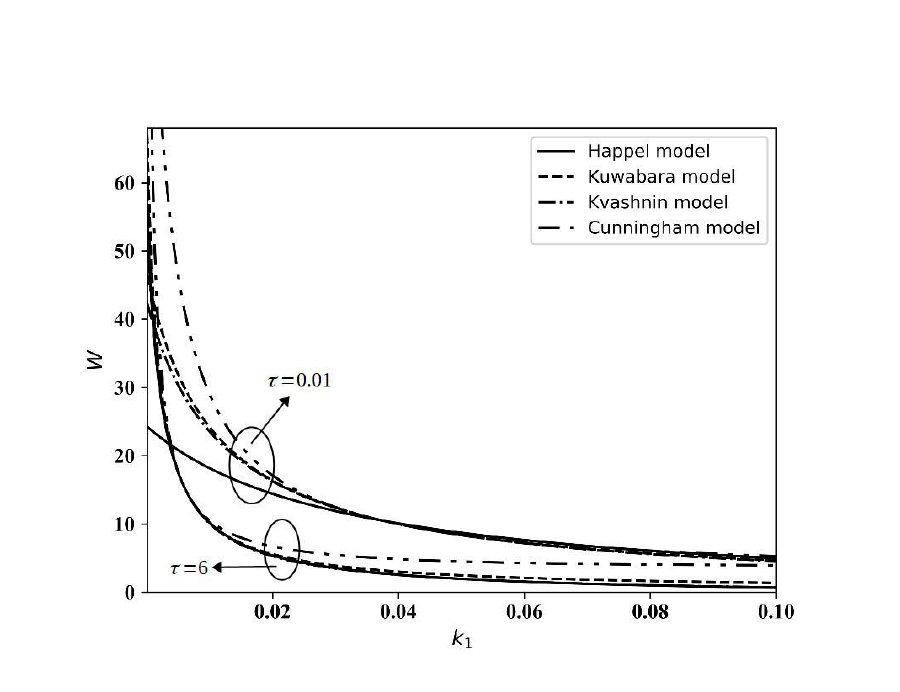
Figure 3. Variation of 𝑊 with 𝑘